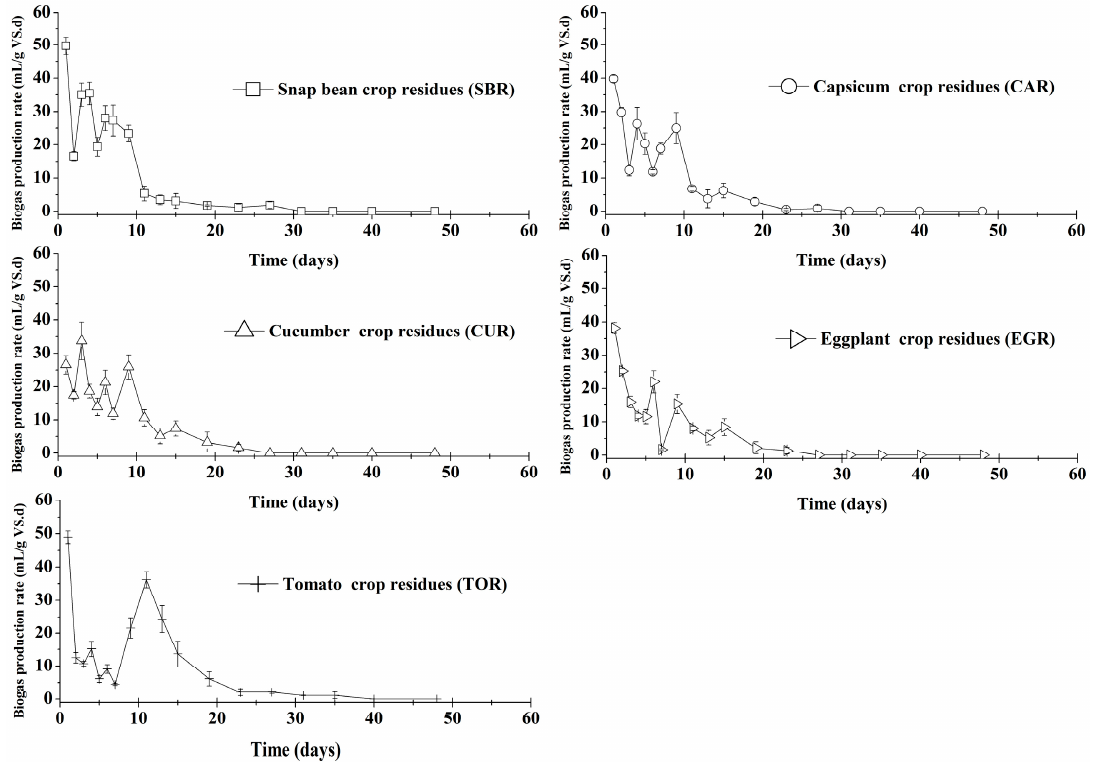
Figure 1. Daily biogas production from different VCRs. The values are means ± standard deviations (vertical bars, n = 3).